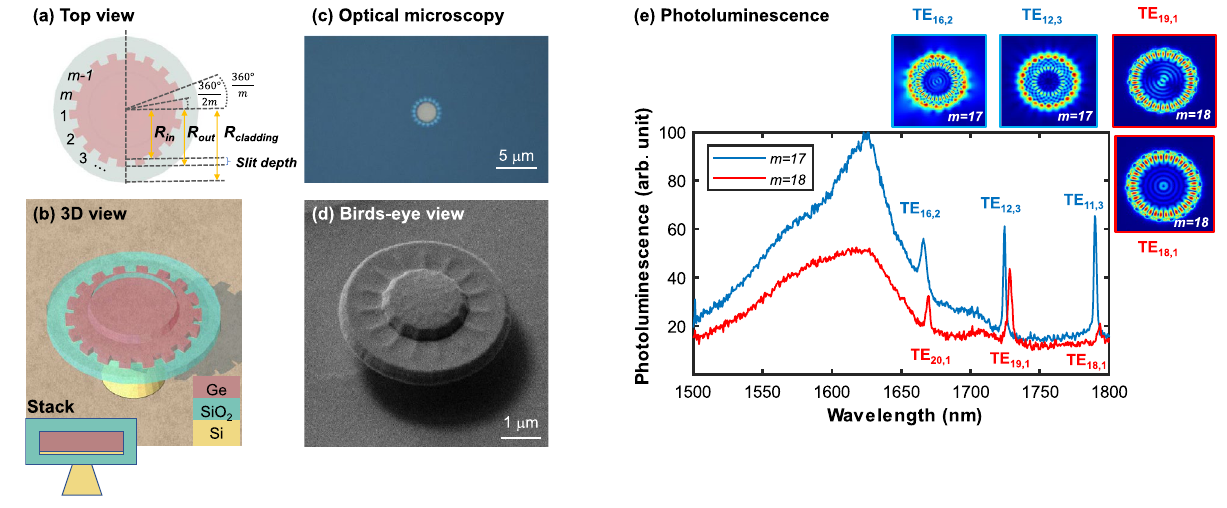
Figure 1. Micro-gear cavity: ( a ) Design parameters including the number of grating periods ( m ), and the slit-depth ( R out – R in ). ( b ) 3D view of a germanium micro-gear cavity with SiO 2 cladding on a Si pedestal, the inset on the bottom left corner represents the stack. ( c ) Optical microscopy image of a micro-gear after etching. ( d ) Birds-eye view using focused-ion beam (FIB) microscope of a fabricated device. ( e ) Photoluminescence spectra of micro-gears of 17 and 18 periods with sharp-peak whispering-gallery modes. The surface plots show the simulated mode profiles represented by the magnitude of the electric field captured at the top surface of the micro-gear as annotated, with blue (red) annotations are used for m = 17 ( m = 18 )